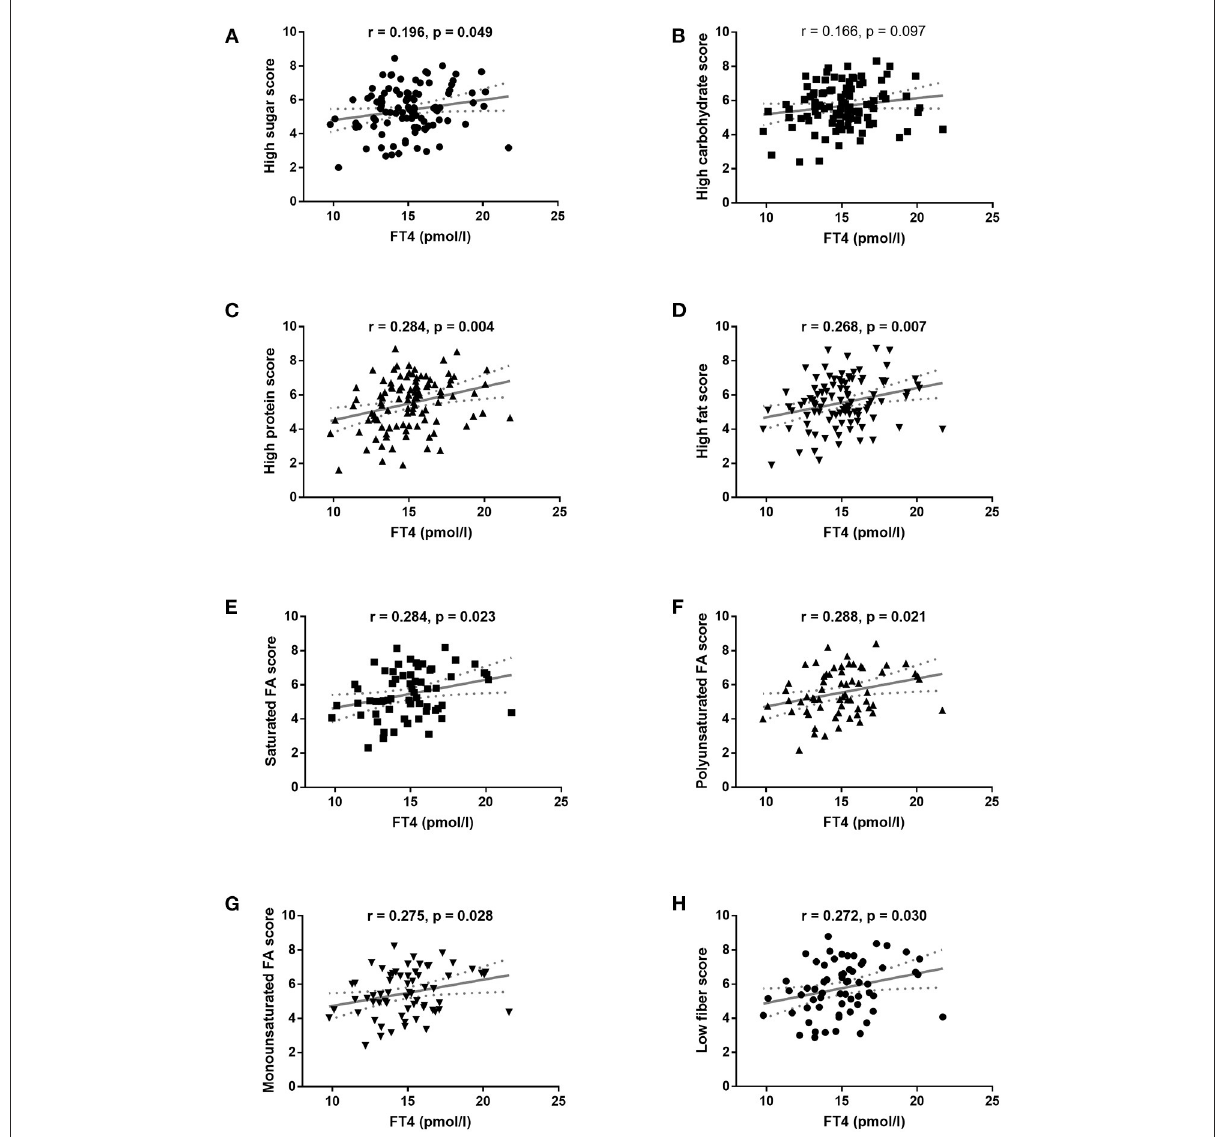
FIGURE2 Pearson’s correlation of food preferences with FT4 serum levels in obese children and adolescents. (A) High sugar score, (B) high carbohydrate score, (C) high protein score, (D) high-fat score, (E) high saturated fatty acid score, (F) high polyunsaturated fatty acid score, (G) high monounsaturated fatty acid score, and (H) low fiber score. Associations were calculated with Pearson’s correlation. The regression line with 95% confidence intervals was calculated in linear regression